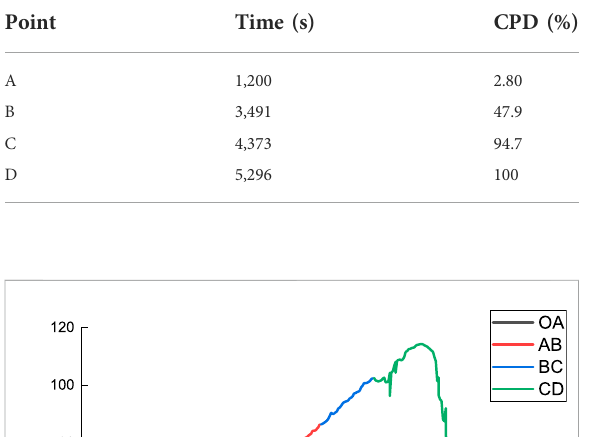
TABLE 6 Percentage of FEs in each of the stages for granite.